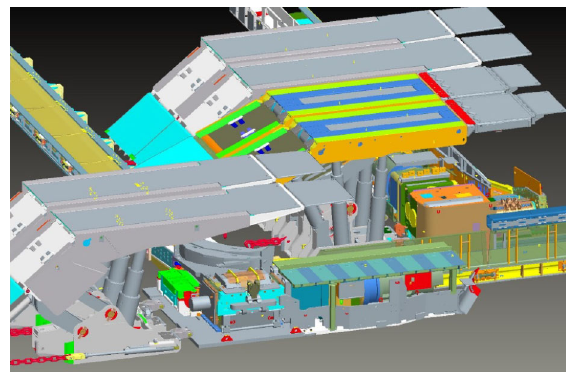
Fig. 8 Cross side-discharge scraper matching